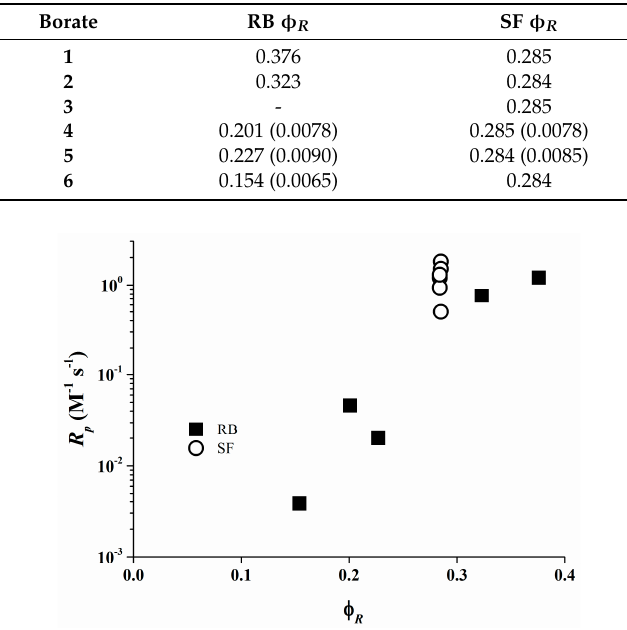
Table 3. Total radical quantum yield φ R formed by reaction of 1.5 × 10 − 2 M of borate salts and Rose Bengal or Safranine O excited states in the photo-polymerizing resin [35]. In brackets: maximum refractive index modulation as obtained in holography recording.